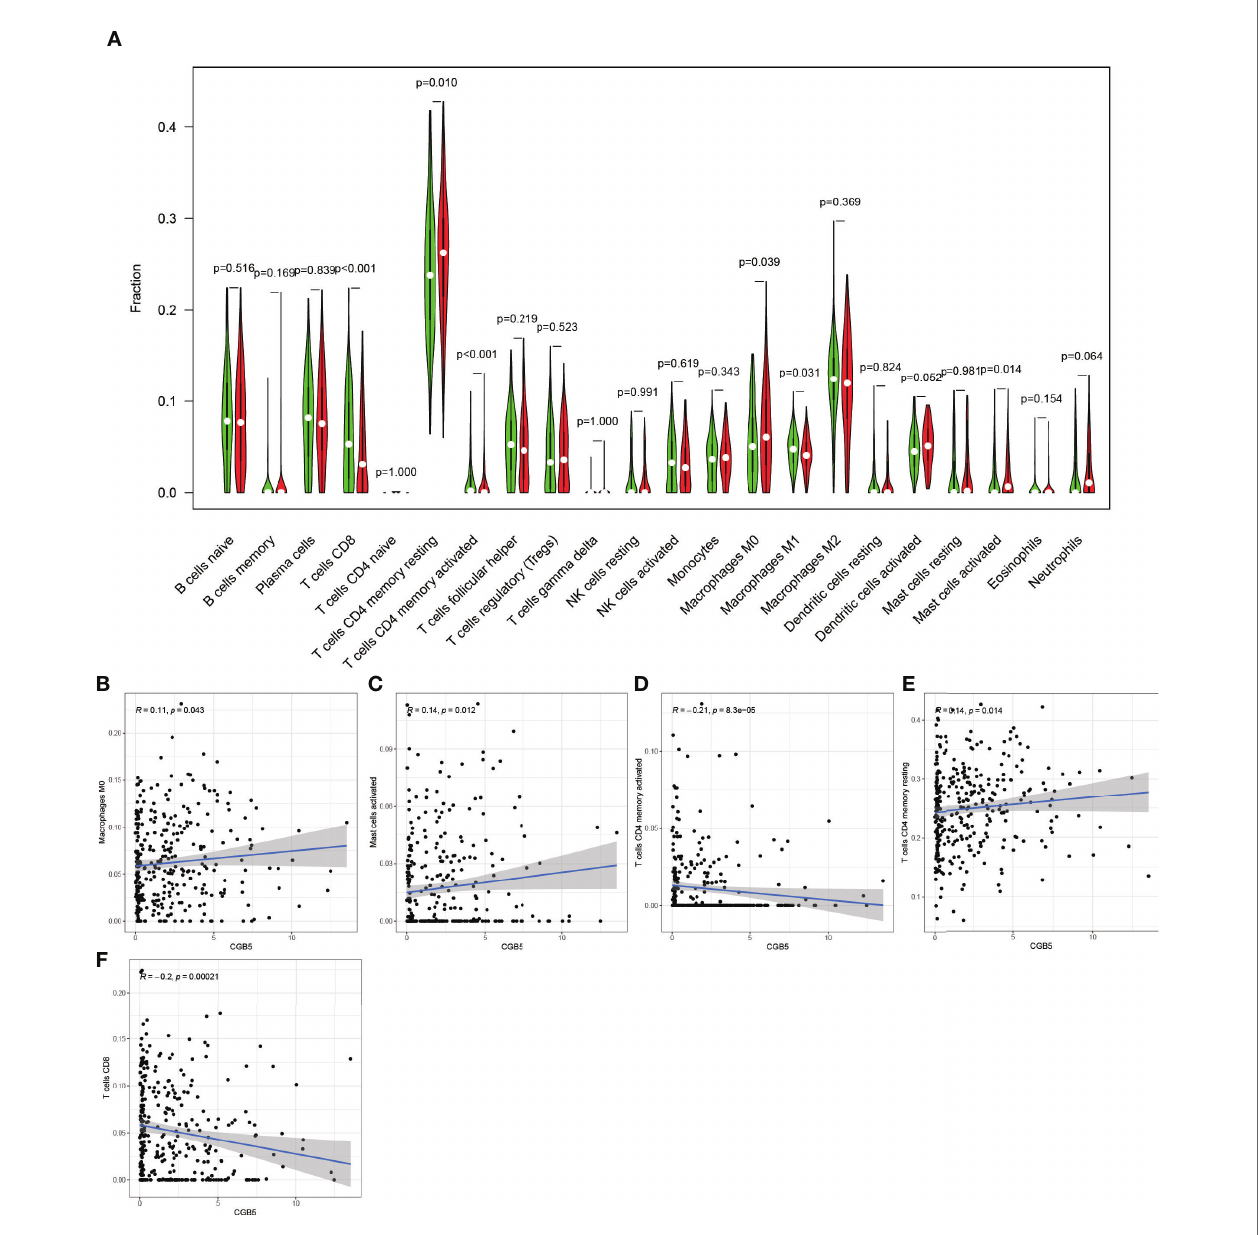
FIGURE 12 | CGB5-based immune cell analysis. The (A) graph shows that there are 5 immune cells associated with CGB5 in gastric cancer (P-value < 0.05). Plots (B, C, E) indicate that these three immune cells are positively correlated with CGB5. plots (D, F) indicate that these two immune cells are negatively correlated with